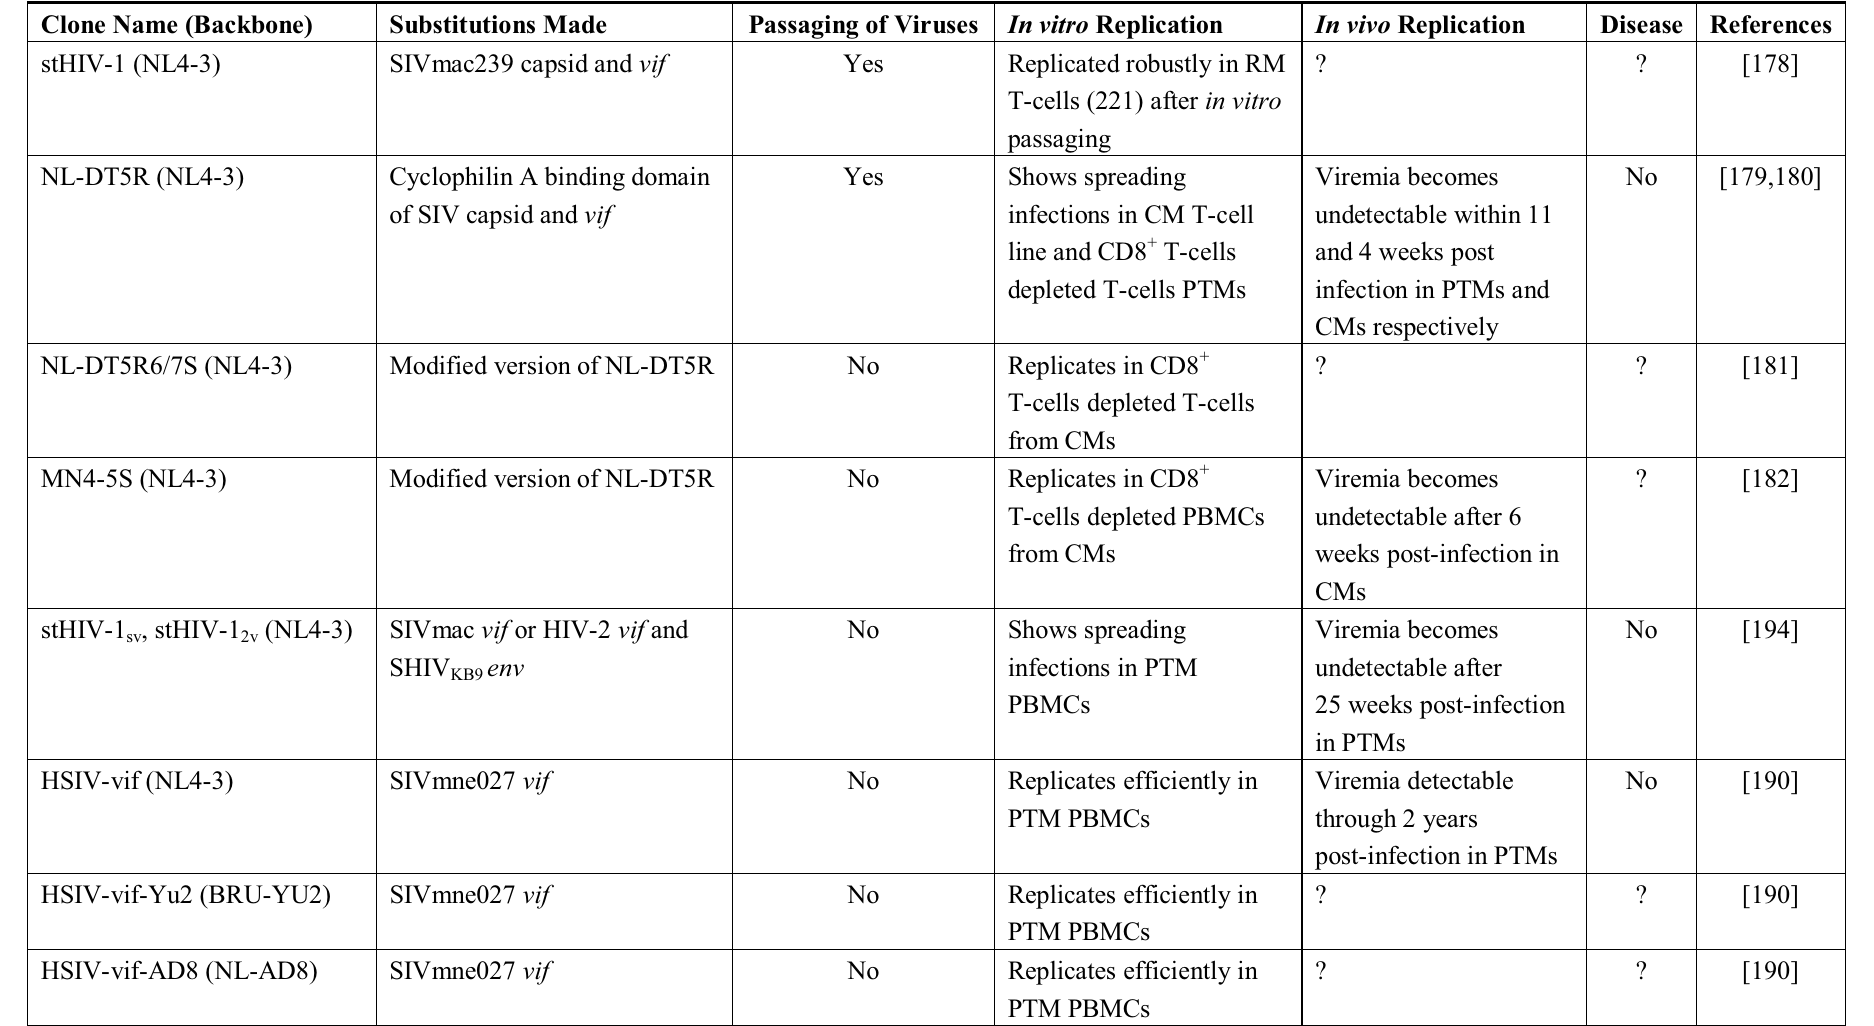
Table 2. Macaque tropic HIV-1